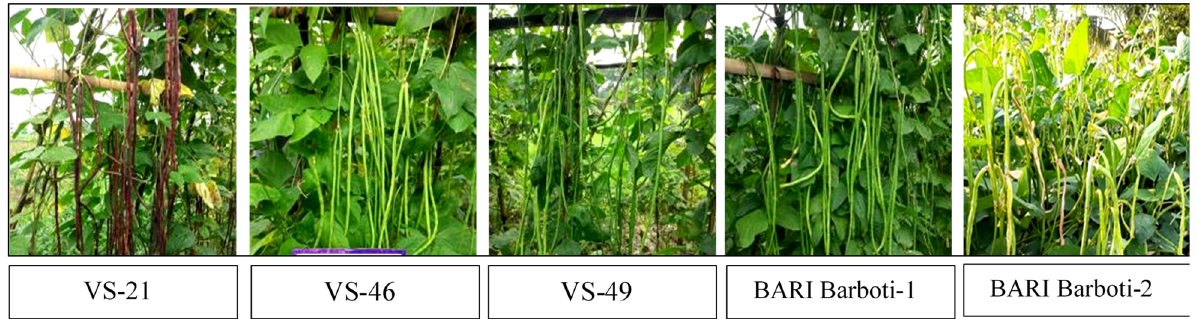
Figure 2. Morphological views of five yard-long bean cultivars commonly grown in Bangladesh.